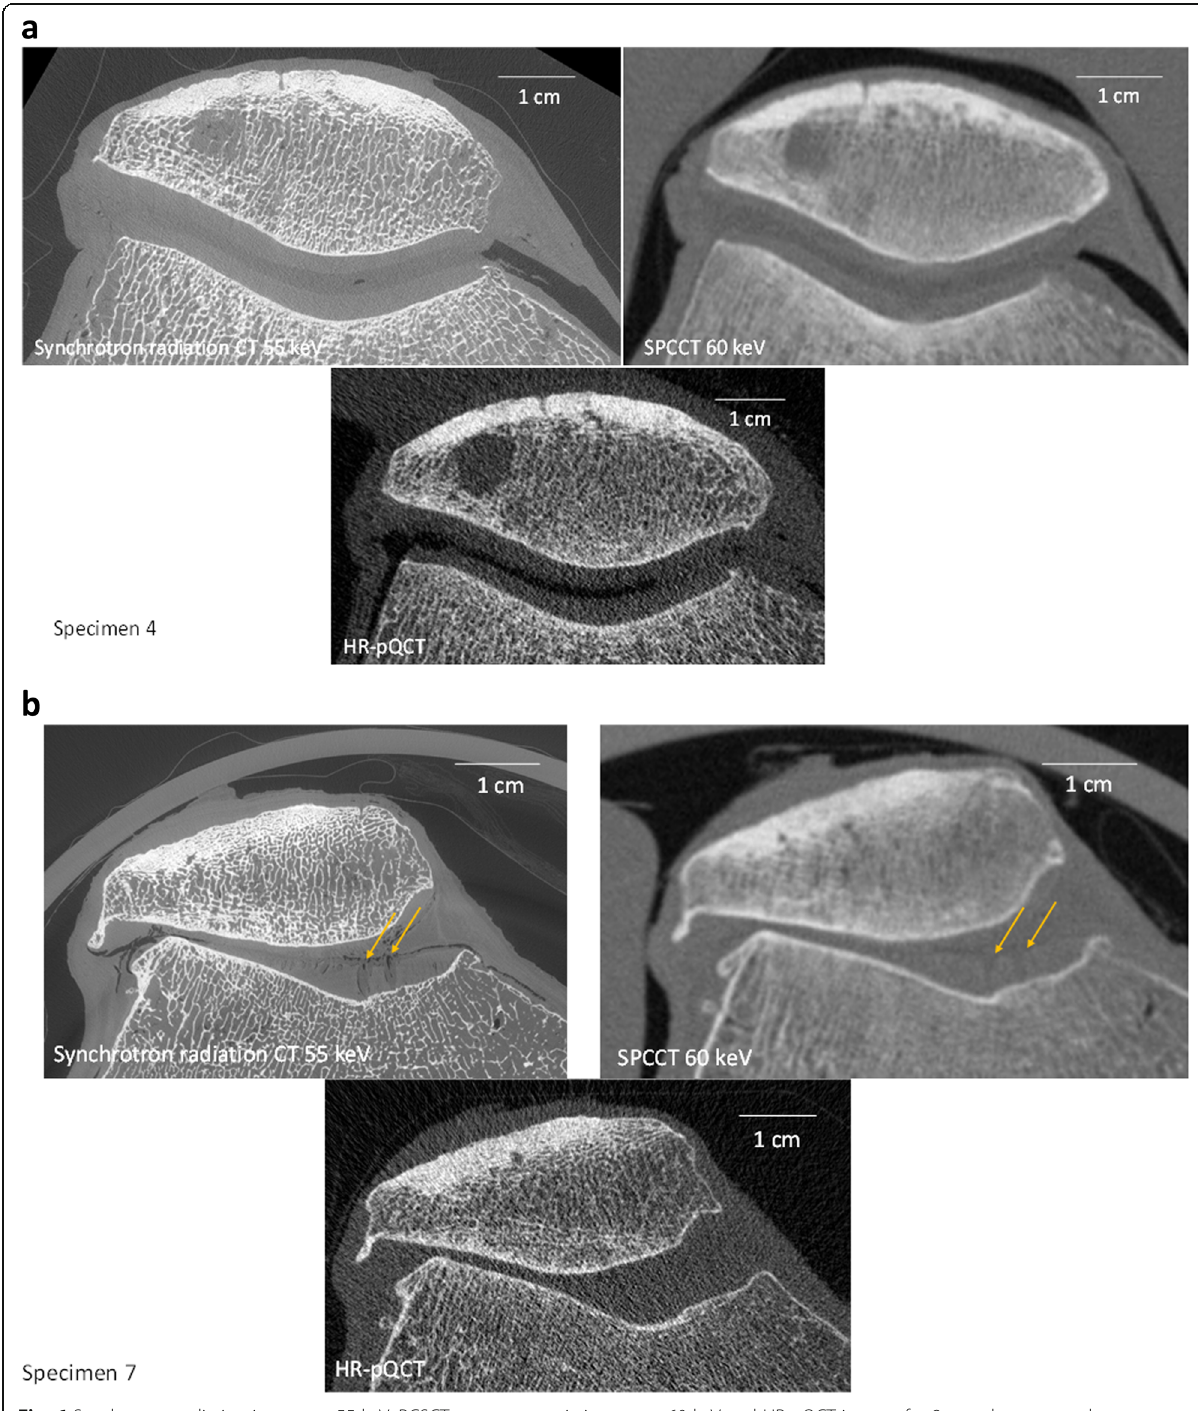
Fig. 6 Synchrotron radiation images at 55 keV, PCSCT monoenergetic images at 60 keV and HR-pQCT images for 2 samples: a normal one (specimen 4); and an osteoarthritic one (specimen 7). The cartilage border with joint space is visible on the monoenergetic images based on synchrotron radiation, taken as references and the virtual PCSCT monoenergetic images. The yellow arrows correspond to cartilage